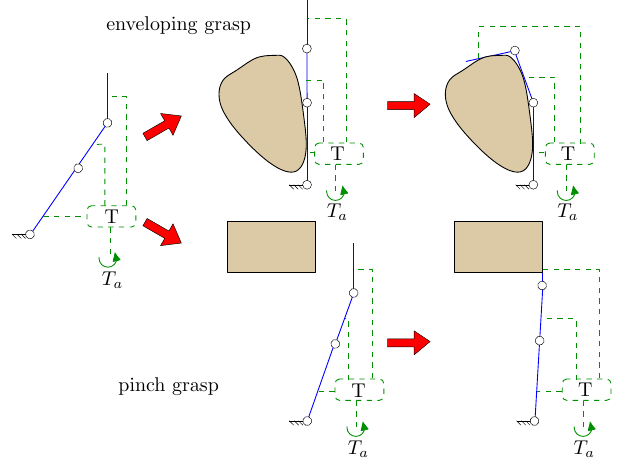
Figure 7. Two possible closing sequences of a three-phalanx finger designed to allow pinch grasps.